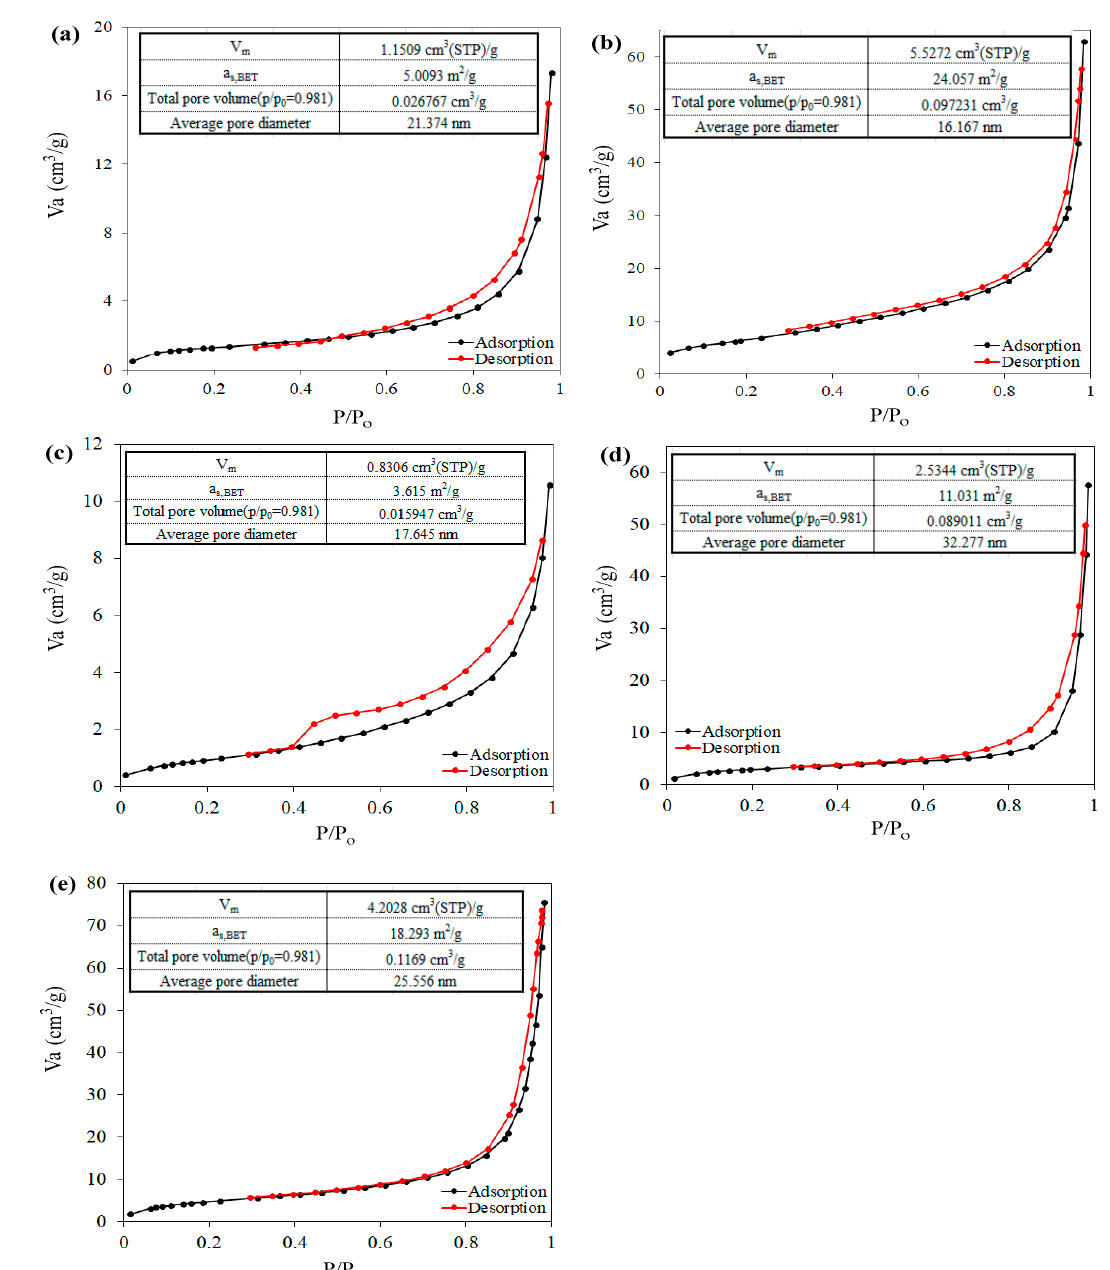
Figure 3. N 2 adsorption–desorption isotherm at temperature of 77 K for ( a ) Cloisite 30B, ( b ) ZnO, ( c ) Ag 2 O, ( d ) Cloisite 30B/Ag 2 O and ( e ) Cloisite 30B/ZnO/Ag 2 O